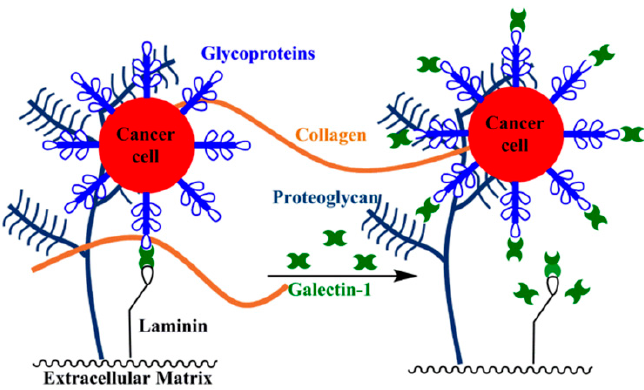
Figure 4. Galectin-1 competitively binds receptors involved in cell–ECM adhesion to promote migration and invasion.